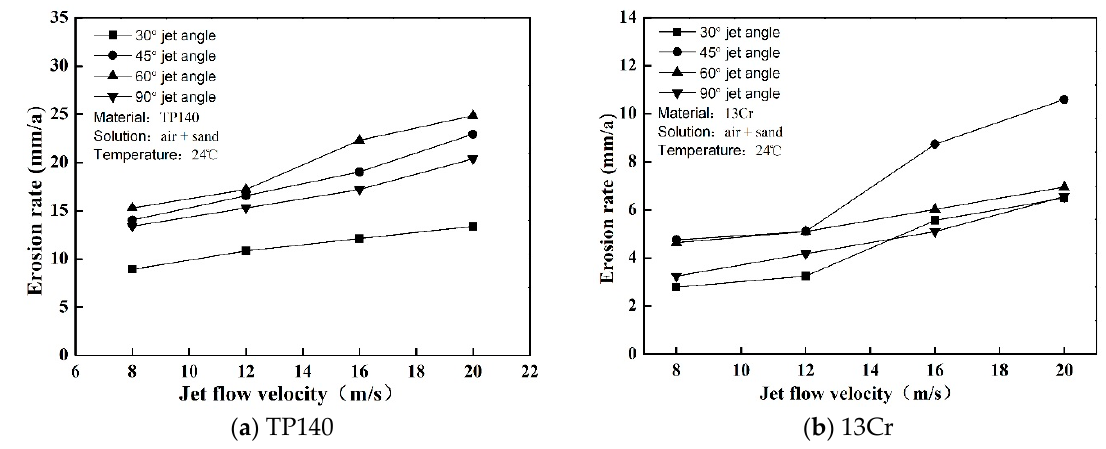
Figure 3. Erosion rate of TP140 and 13Cr under gas–solid jet flow.